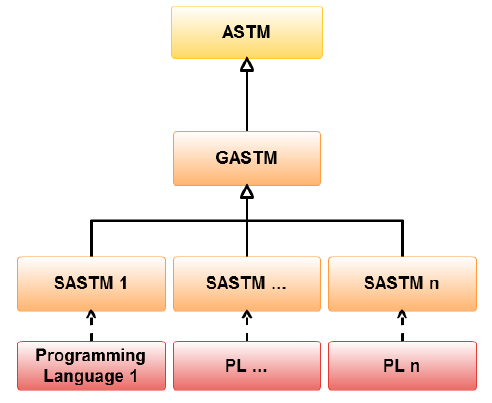
Fig. 2. SATSM - GASTM